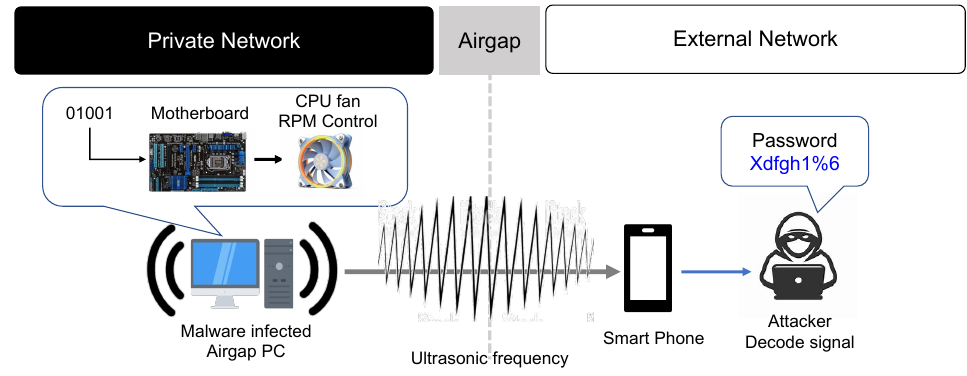
Figure 13. Conceptual diagram of air-gap attack using PC fan